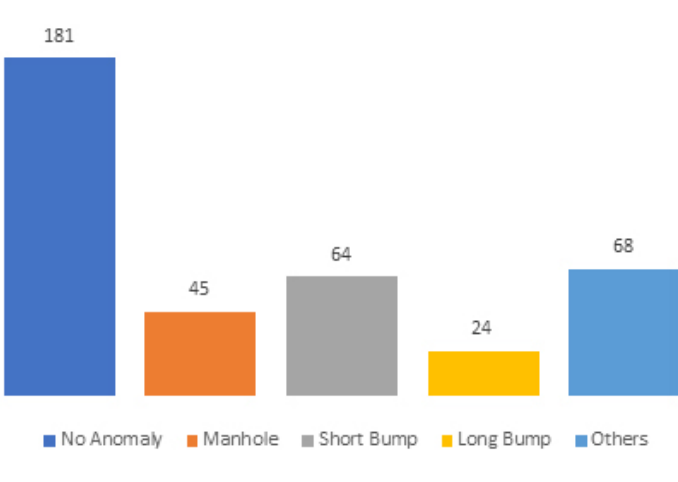
Figure 6. Anomalies recognised by the system.